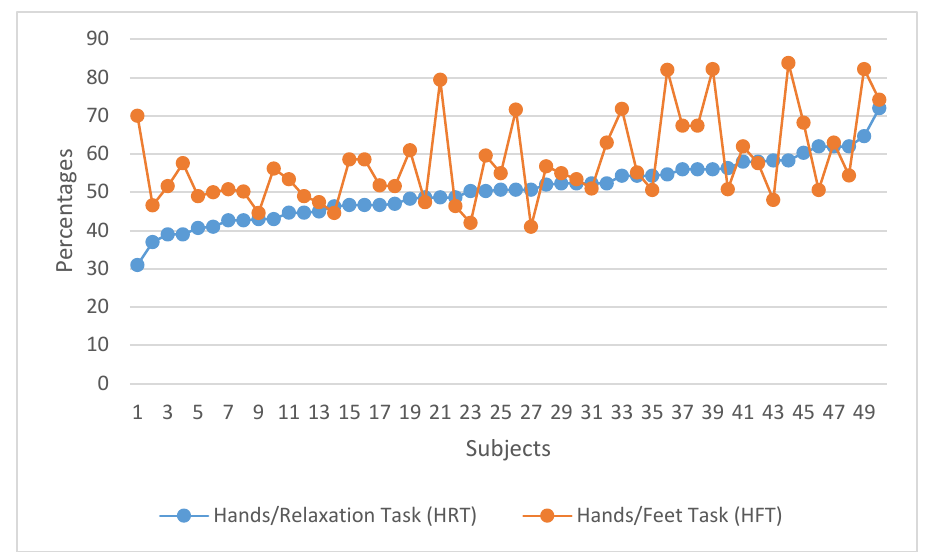
Figure 6. Individual task performance in HRT vs. HFT.